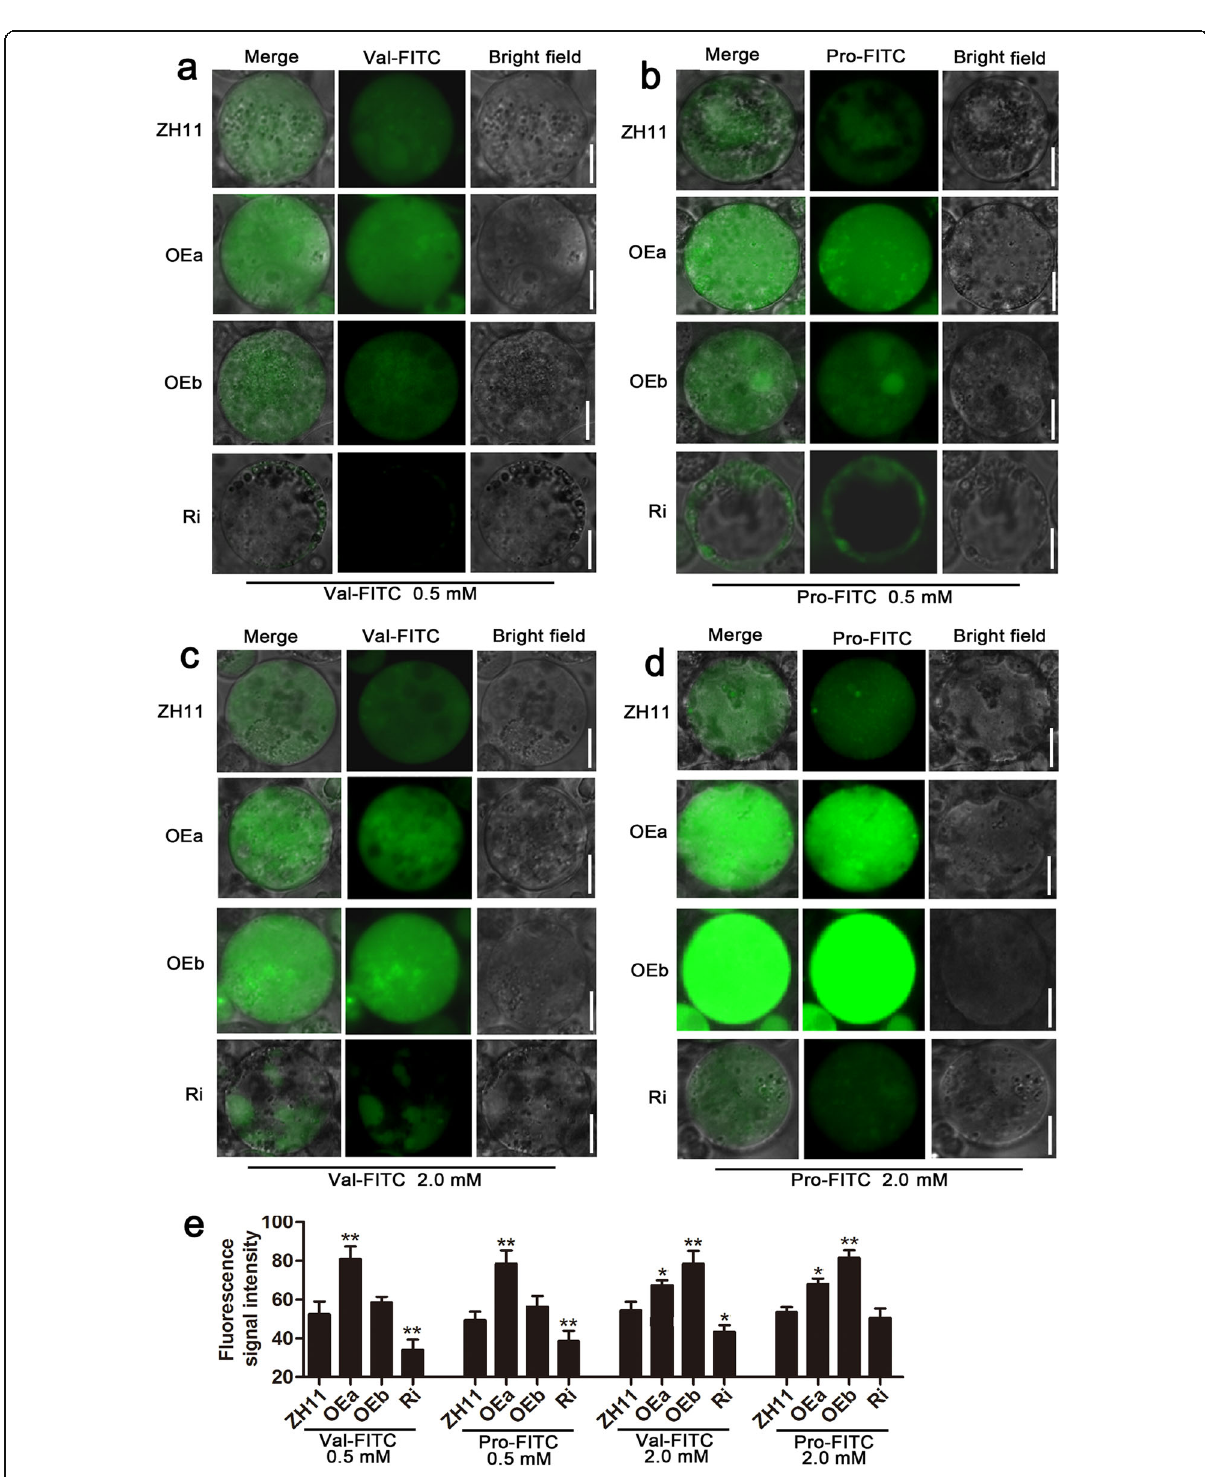
Fig. 6 Protoplast amino acid-uptake assay among ZH11, OEa, OEb, and Ri lines. Fluorescence was detected after culturing protoplasts with FITC- labeled amino acids for 4 h. Green fluorescence images of ZH11 and OEa, OEb and Ri lines under treatment with 0.5 mM Val-FITC ( a ), 0.5 mM Pro- FITC ( b ), 2.0 mM Val-FITC ( c ), and 2.0 mM Pro-FITC ( d ). e Detection of cell fluorescence signal intensity in ( a - d ). Fluorescence intensities were normalized to the area of the respective cell by ImageJ software, and a total of 100 cells were statistically analyzed. Scale bars, 5.0 μ m ( a - d ). The letters above the error bars are ranked by the T test, “ * ” indicates a significant difference at p < 0.05, and “ ** ” indicates a significant difference at p < 0.01. Values are means ± s.d. ( n =